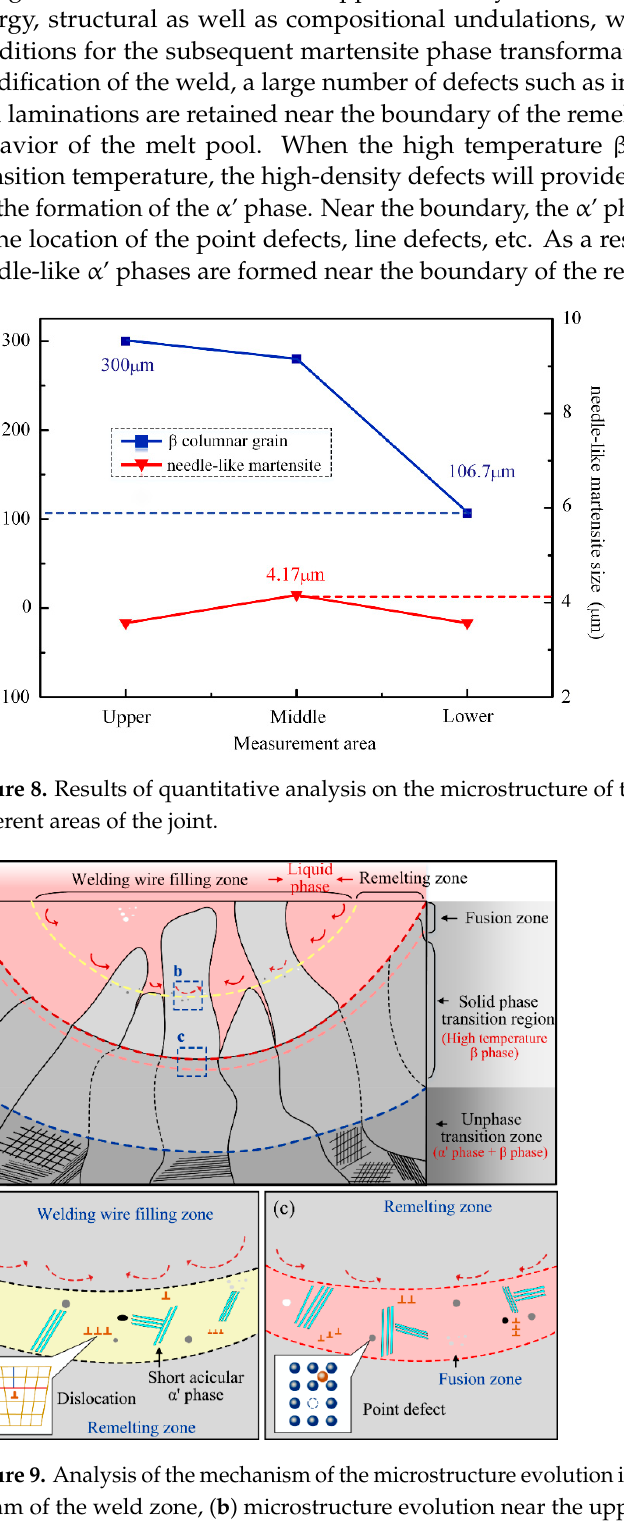
Figure 9. Analysis of the mechanism of the microstructure evolution in the interlayer weld area: ( a ) diagram of the weld zone, ( b ) microstructure evolution near the upper boundary of remelting zone, ( c ) microstructure evolution of the fusion zone.